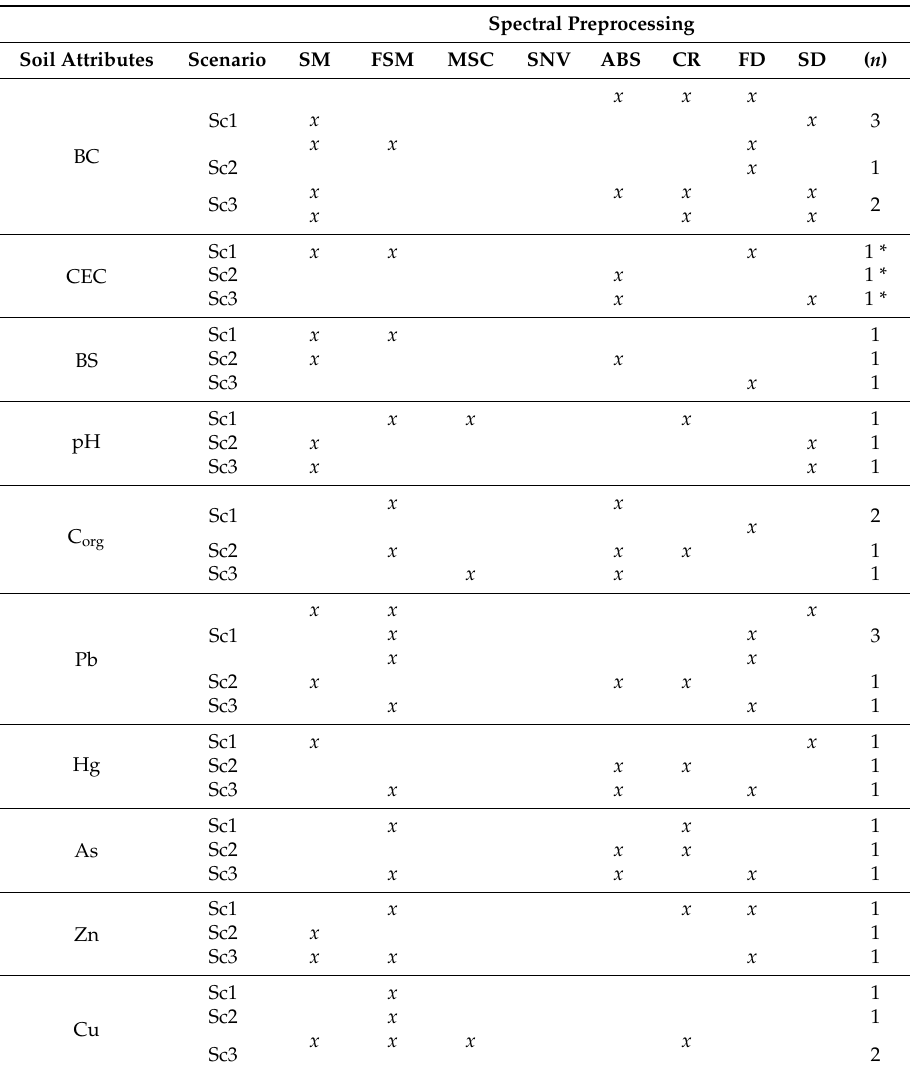
Table 4. Statistics on the spectral preprocessing techniques of the best models found for the selected soil attributes while using PLSR modelling (SM: smoothing, FSM: final smoothing, MSC: Multiplicative Scatter Correction, SNV: Signal Normal Variate, ABS: absorbance, CR: continuum removal, FD: first derivative, SD: second derivative, ( n ): number of models found fulfilling the selection criteria: employed maximum of up to five PC’s, reached RPD higher than 1.5 and achieved the highest R 2 test, * model RPD was